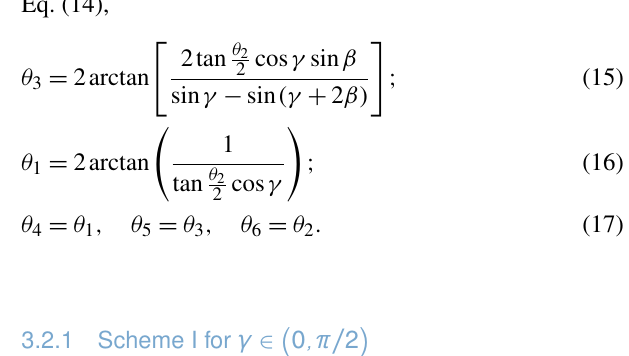
(cid:0) 0 ,π/ 2 (cid:1) 3.2.1 Scheme I for γ ∈ When γ ∈ (0 ,π/ 2) (see Fig. 4), the relationship between upper-dihedral angles and revolute variables is